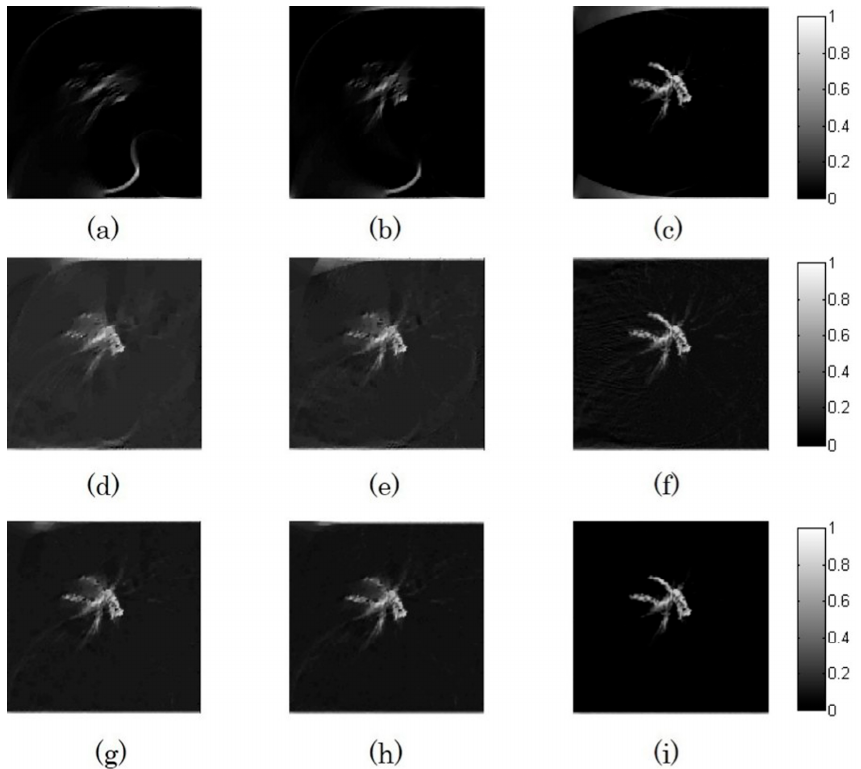
Figure 13. The reconstructed images from the phantom in Figure 10 by the TV-GD, TV-VB and